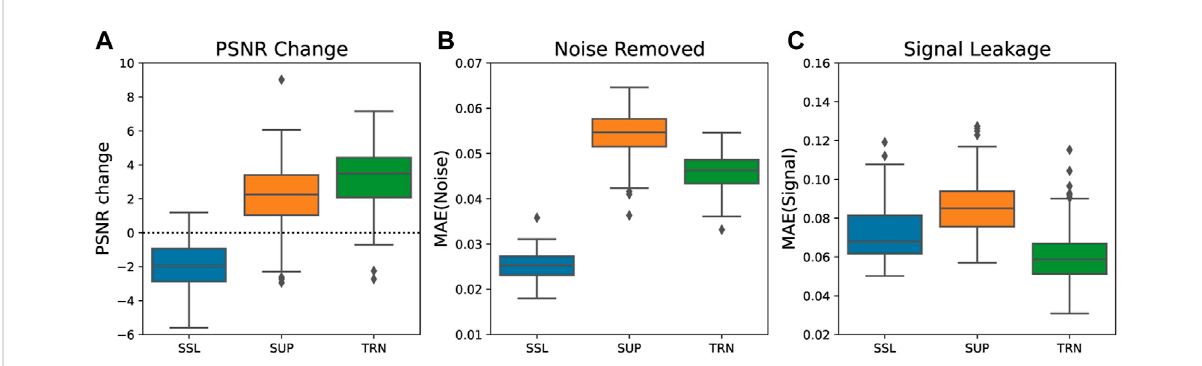
FIGURE 7 Comparisonofdenoisingperformanceofthedifferentnetworks:fullyself-supervised(SSL),fully-supervised(SUP),andthenetworkpre-trained in a supervised manner prior to self-supervised, fi ne-tuning (TRN). The box plots show for 100 events the (A) overall change in PSNR, (B) volume of noise removed, and (C) shows the amount of signal leakage encountered. The dashed line in (A) indicates a benchmark against the PSNR of the original, noisy